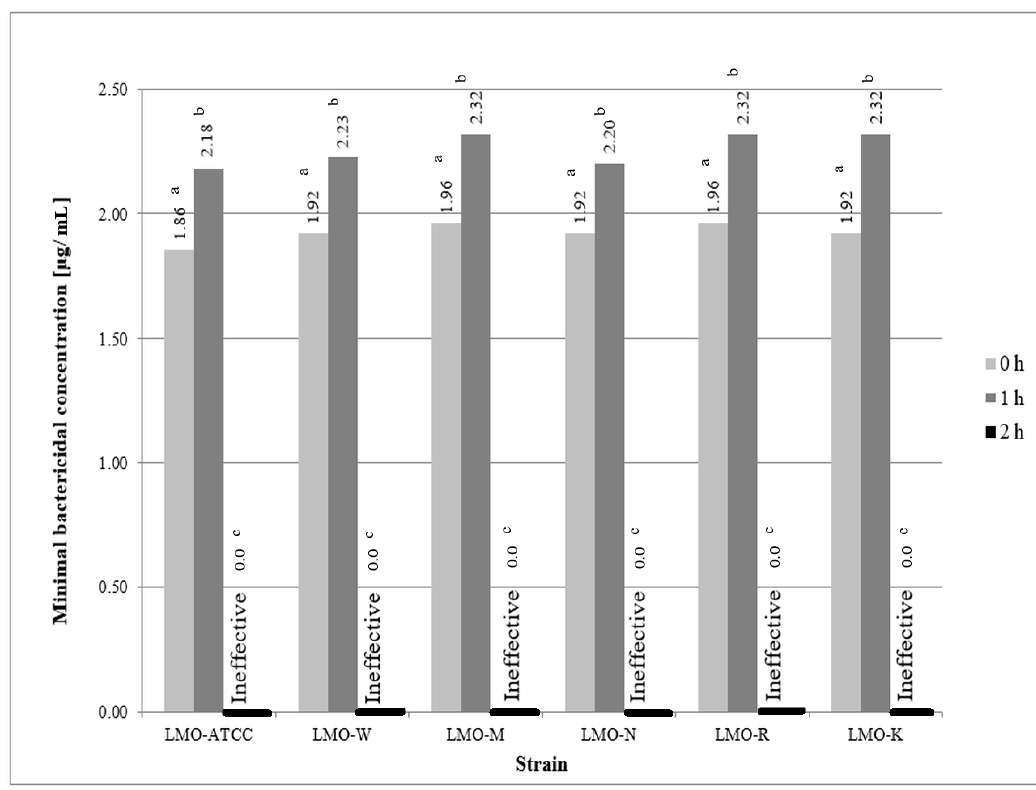
Figure 1. Effectiveness of ozonated water against the tested strains of L. monocytogenes ( LMO ‐ ATCC— L. monocytogenes ATCC 19111, LMO ‐ W—strain isolated from vegetables, LMO ‐ M—strain isolated from meat, LMO ‐ N—strain isolated from dairy products, LMO ‐ R—strain isolated from fish, LMO ‐ K— clinical strain . ; a,b,c—variables with different letters are statistically different ( p ≤ 0.05).